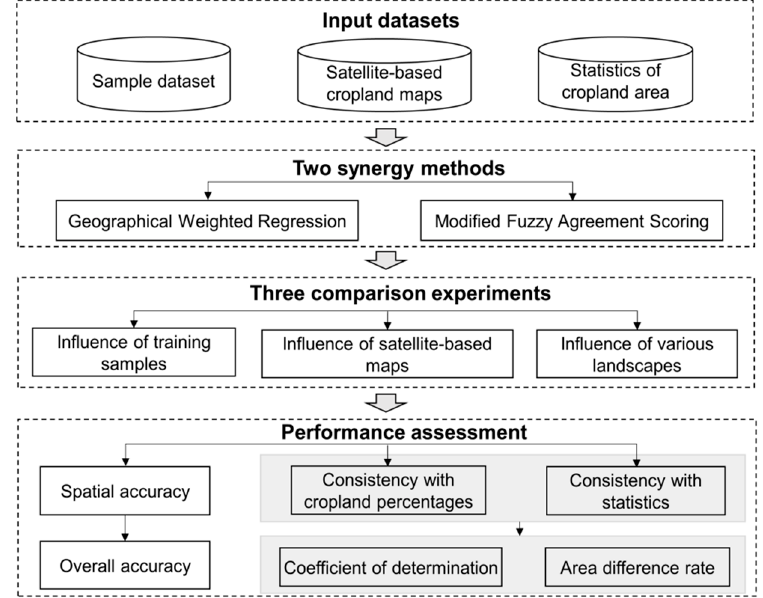
Figure 1. The flowchart of the comparison experiments.